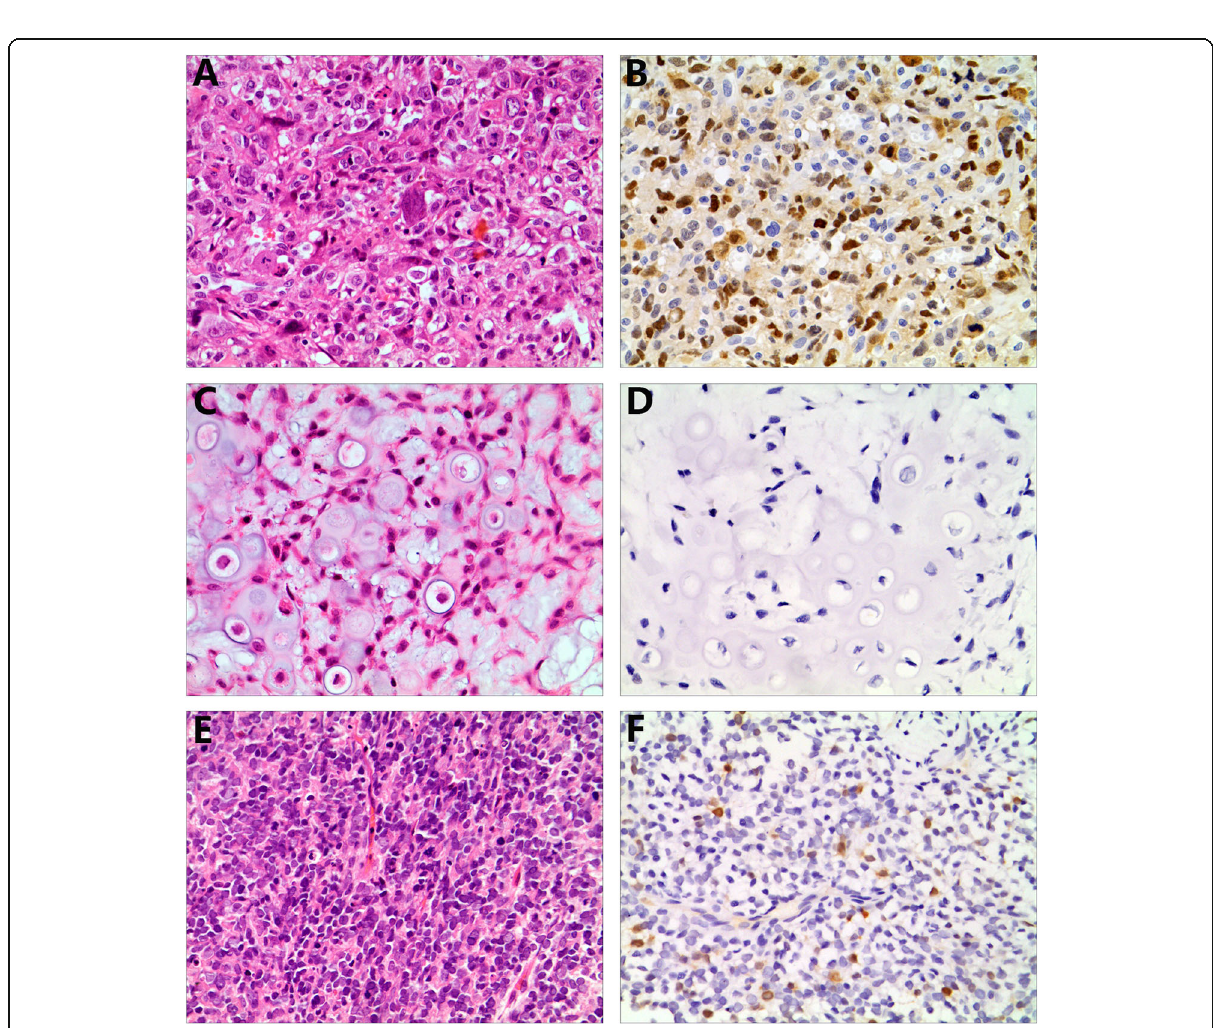
Fig. 1 KPNA2 immunostaining in osteosarcoma, chondrosarcoma and Ewing sarcoma samples. Osteosarcoma samples ( a ) showed strong staining for KPNA2 ( b ). Chondrosarcoma ( c ) and Ewing sarcoma ( e ) samples were negative for KPNA2 ( d and f ). ( a – f ×